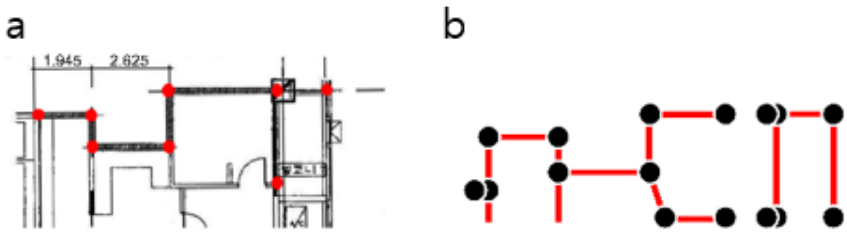
Table 10. Confusion matrix of node extraction. Prediction Actual 0 Figure 9. Wrong Prediction: ( a ) floorplan with diagonal wall; (b) original floorplan with furnishing; ( c ) ground truth pixel; (d) prediction pixel; (e) generated vector. Finally, wall thickness, as measured by the number of pixels occupied by each wall, was added to the automatically generated vector. An example of the measurement of the thickness of each wall by the method described in Section 2.2.3 is shown in Figure 10. Of the numbers in parentheses, the first number represents wall thickness from the results of wall segmentation, and the second number represents thickness from ground truth.